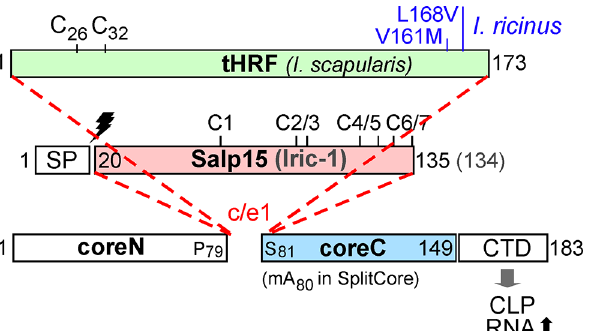
Fig 1. Primary sequence features of tick saliva proteins to be presented on HBc CLPs. Numbers refer to amino acid positions; the bars are drawn to scale. Amino acid exchanges in I . ricinus versus I . scapularis tHRF are indicated in blue. Salp15 and Iric-1 differ by one aa in length. In ticks, both are produced as precursors carrying a cleavable N terminal signal sequence (SP; cleavage site indicated by the lightning symbol) which was deleted in the constructs used here. The seven Cys residues are consecutively labeled C1, C2 and so forth, with the marks indicating their positions. For contiguous chain HBc fusion constructs the heterologous sequences were inserted, via short linkers, between P79 and S81; for separate expression of core N and coreC in the SplitCore system, the coreC segment starting with A80 was provided with an artificial methionine start codon (m). HBc183 constructs comprise the CTD that mediates efficient encapsidation of bacterial